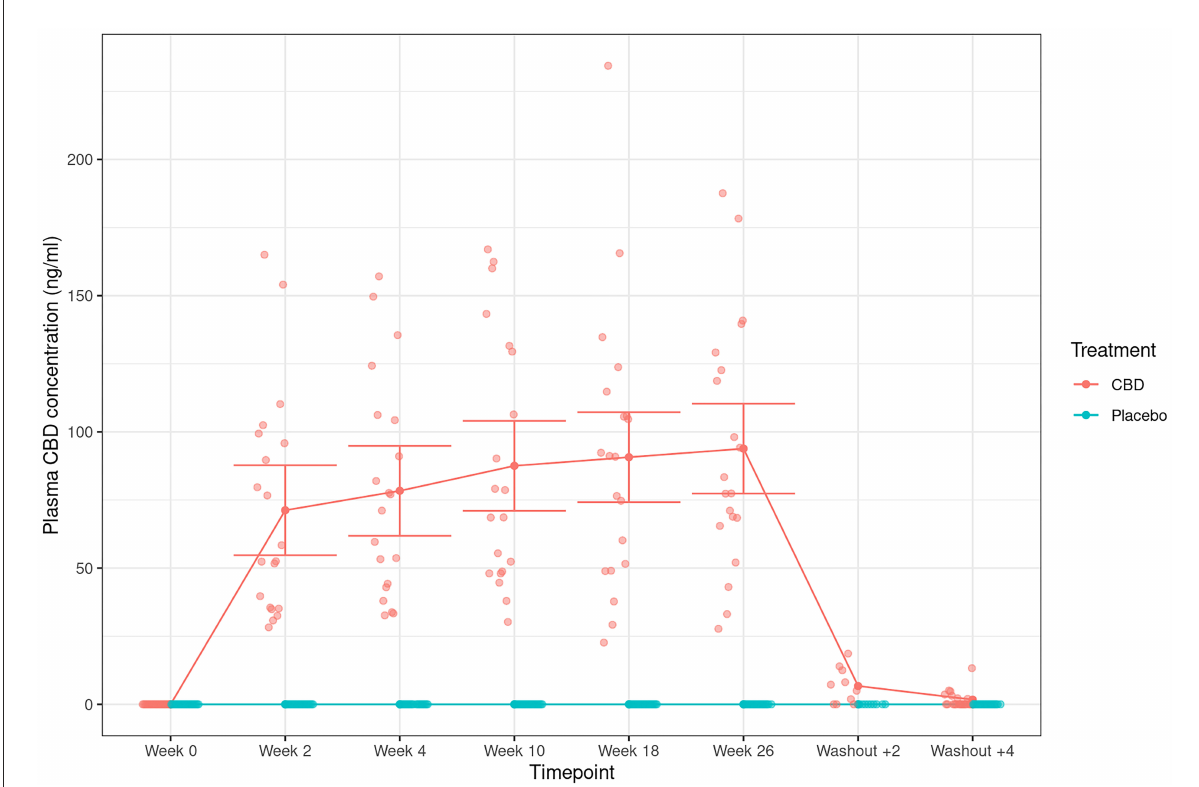
FIGURE7 Plasma CBD concentrations (ng/ml; mean and 95% confidence intervals) in dogs dosed with CBD (red) and placebo (blue) at each study time point. Week 0 depicts the baseline. Solid red line shows the mean concentration across the time points in CBD-dosed